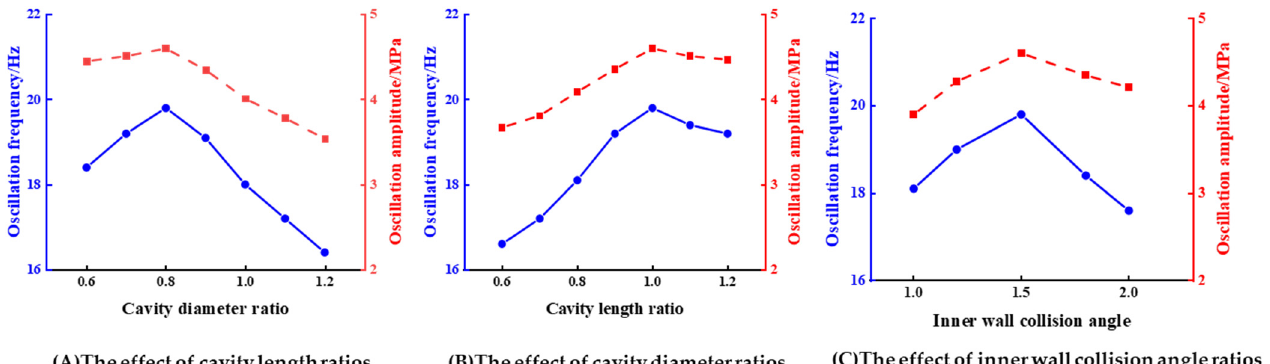
Figure 6. Influence of dimensionless structural parameters on the oscillation characteristics. ( A ) Influence of the cavity length ratios on oscillation characteristics. ( B ) Influence of cavity diameter ratios on oscillation characteristics. ( C ) Influence of inner wall collision angle ratios on oscillation characteristics.